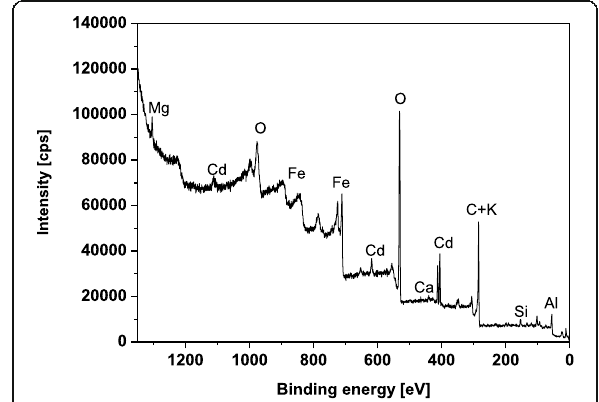
Fig. 8 XPS full spectra of MBC2 after Cd(II) sorption